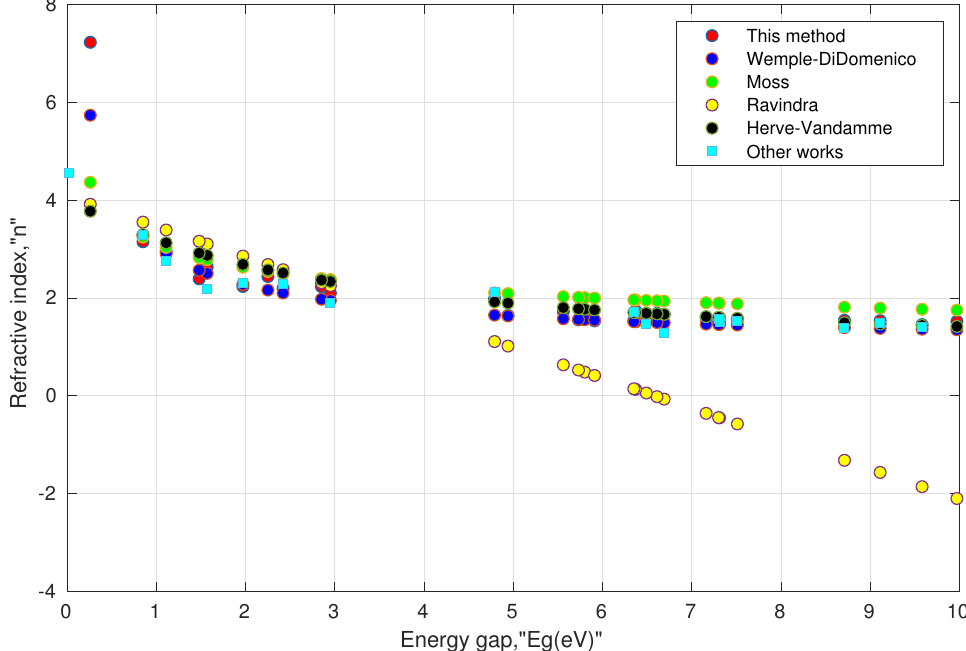
Figure 3. Simulated behavior of various models for halide perovskites, shown in Table